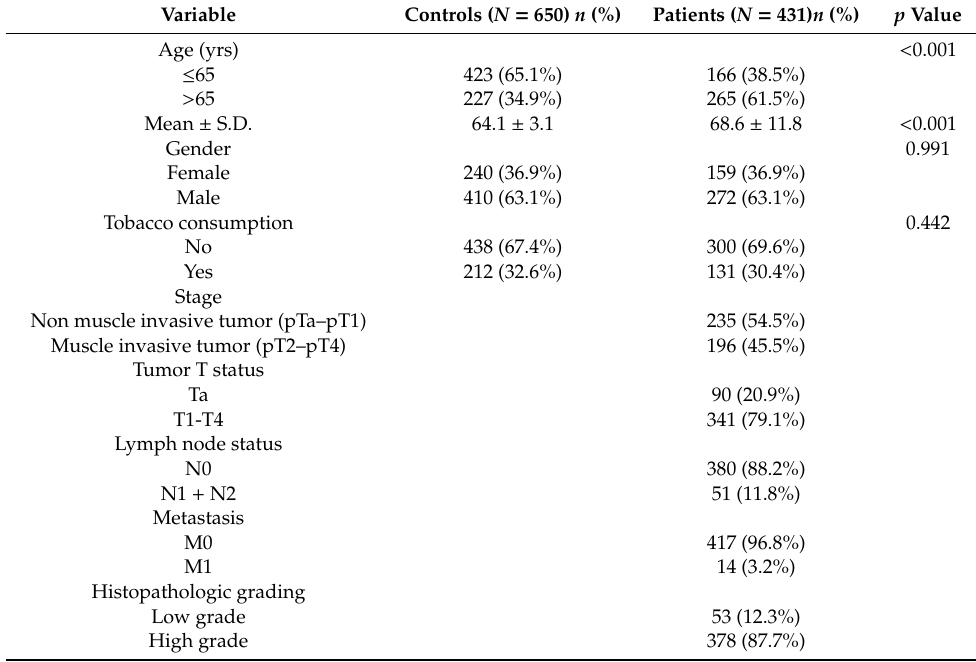
Table 1. The distributions of demographical characteristics in 650 controls and 431 patients with UCC.